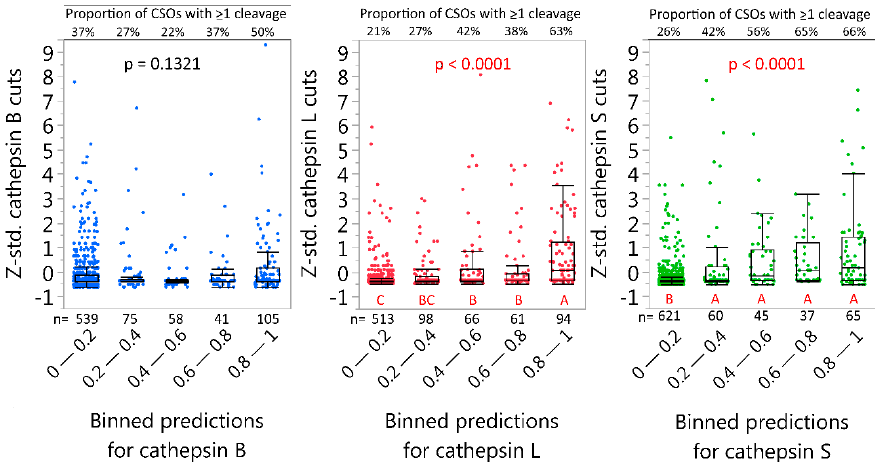
Figure 2. Comparison of predicted and observed cleavage of CNS proteins. All potential cleavage site octamers (CSOs) within alpha-synuclein, recombinant myelin basic protein isoforms 2 and 6, and tau were binned into ranges of 0.2 based on the predicted cleavage probability (X-axis). Intra-protein z-standardized number of observed cuts after 24 h at corresponding CSOs are depicted on the Y-axis. The p -values indicate Welch ANOVA significance for cathepsin B/L/S (F(4, 1.53/13.03/12.24)) and di ff ering letters indicate binned groups that have significant di ff erence in mean number of observed cleavages (Tukey–Kramer, HSD). Whiskers are outlier box-plots.